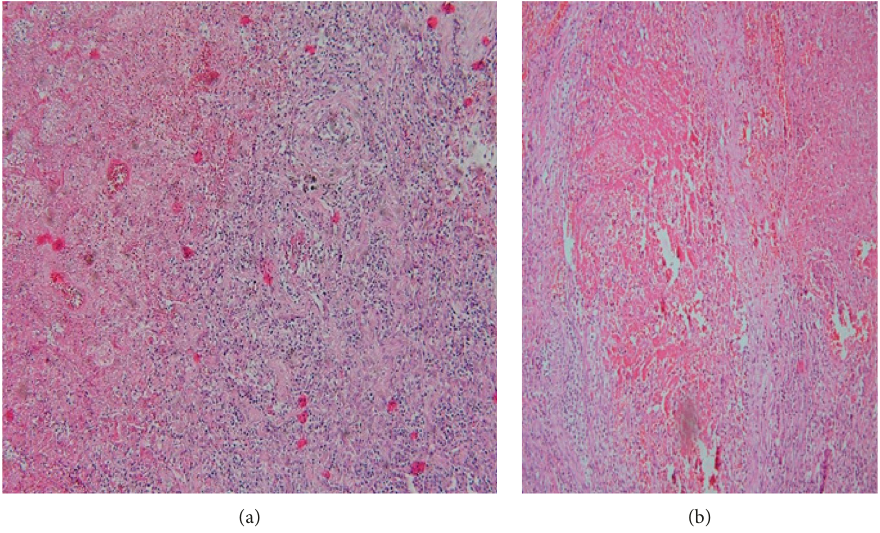
Figure 4: Nonnecrotizing granuloma in conjunction with a large area of